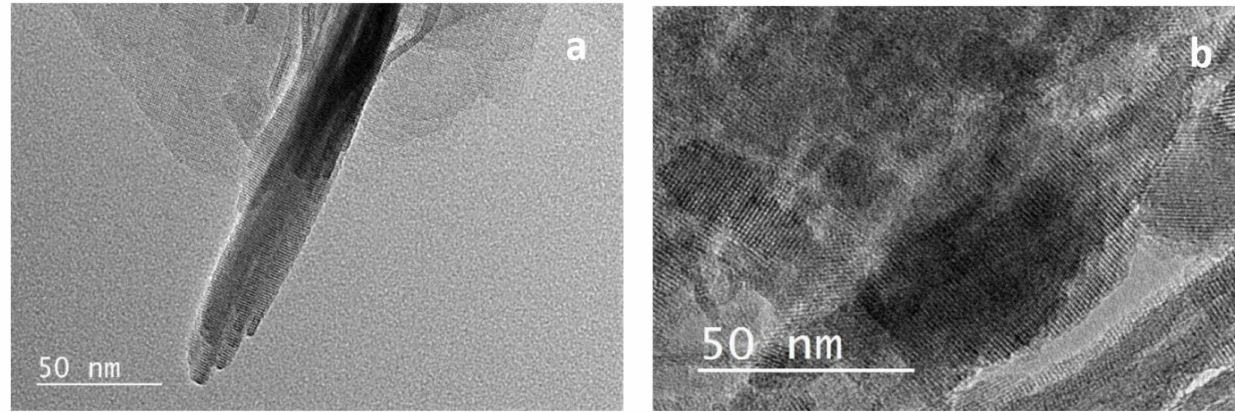
Figure 3. Transmission electronic microscopy (TEM) images of ( a ) NSh-HZSM5 and ( b ) NS-HZSM5. When 18-N 3 -18 was used as structure directing agent, the increase in the quaternary ammonium number and in carbon chain length produced the morphology of the NS- HZSM5 nanosponges (Figure 2d). The nanomaterials show to be spiky-like and